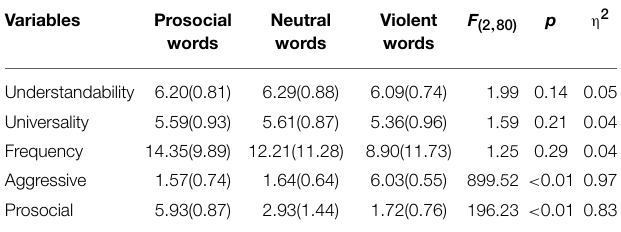
TABLE 1 | F -test for every dimension of different video games. TABLE 2 | A comparison of subjective ratings of the three word